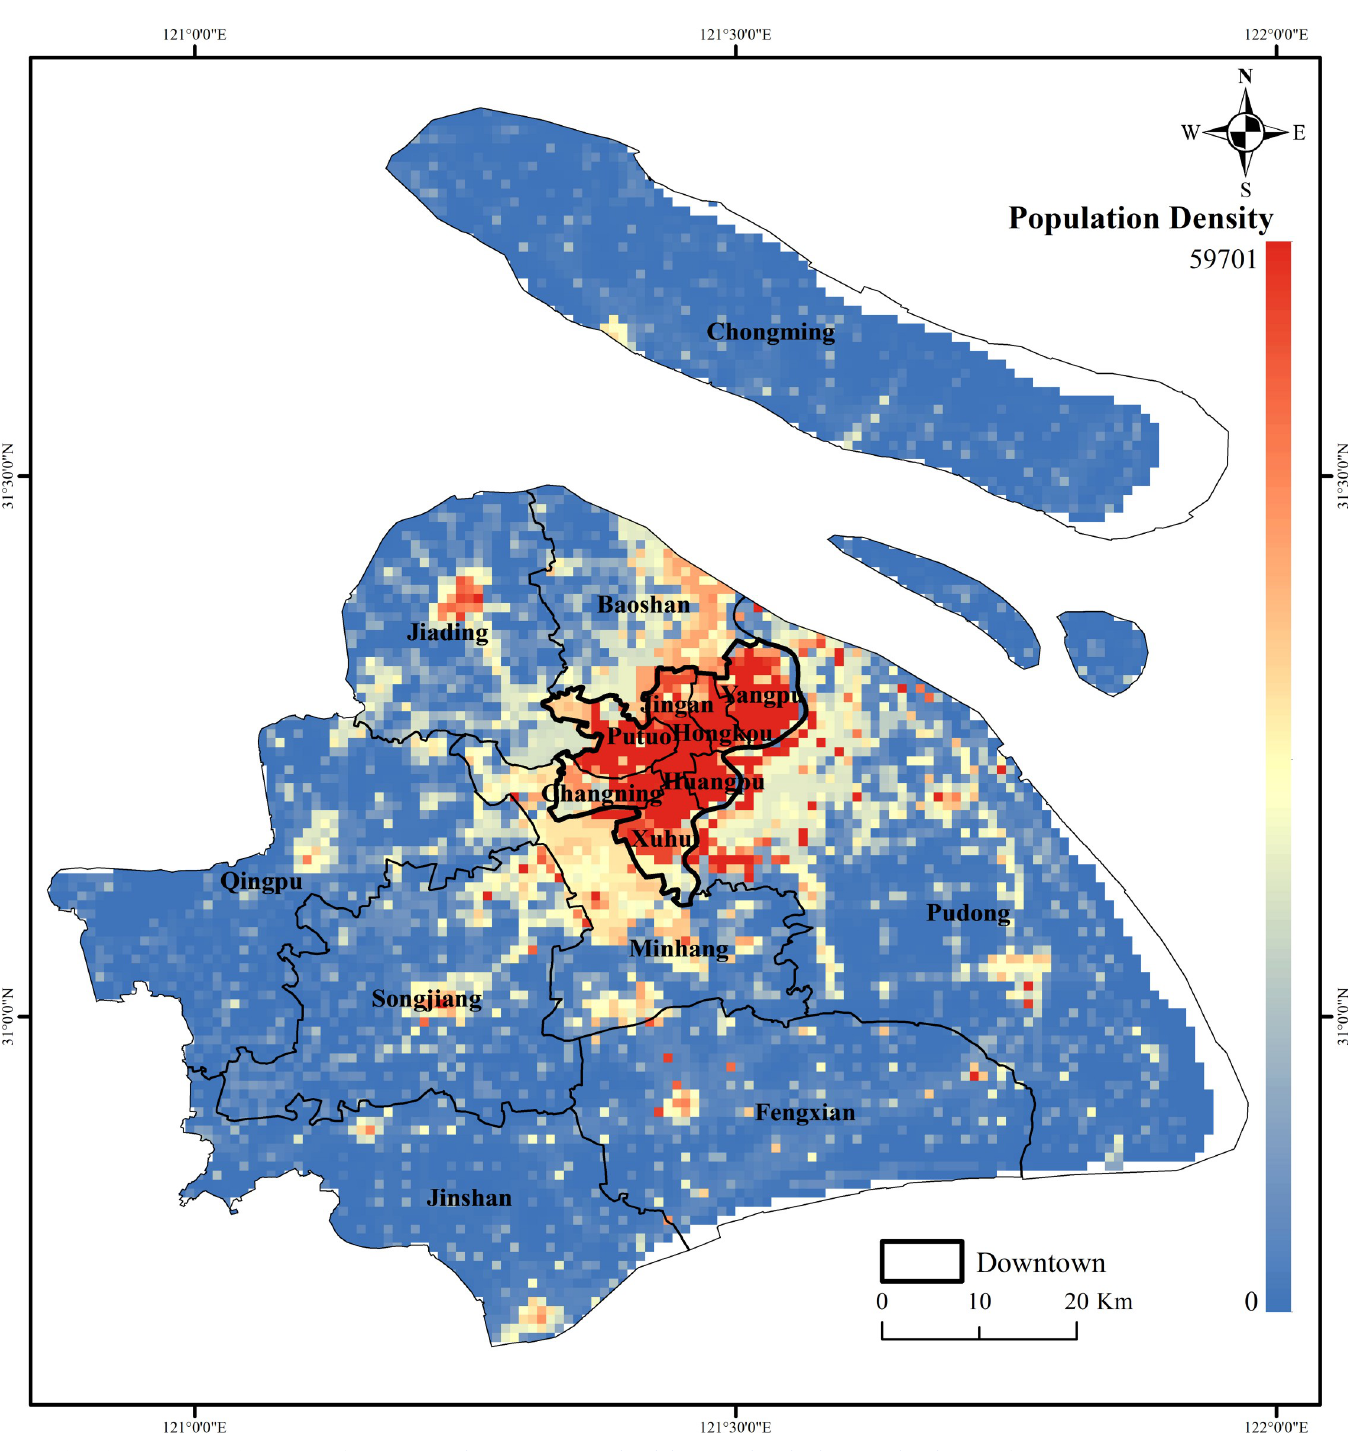
Fig 2. Shanghai population distribution. (Image Source: https://www.naturalearthdata.com/downloads/10m-cultural-vectors/).